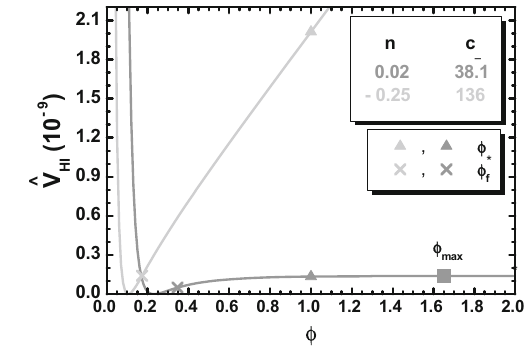
Fig. 4 The inflationary potential (cid:12) V HI as a function of φ for K = K 2 or K 3 , φ (cid:14) = 1 and n = 0 . 02 (gray line) or n = − 0 . 25 (light gray line). The values corresponding to φ (cid:14) , φ f and φ max (for n = 0 . 02) are also indicated specifically, we find λ = 9 . 7 · 10 − 4 or 5 . 3 · 10 − 3 and c − = 38 . 1 or 136, with M = 0 . 23 or M = 0 .